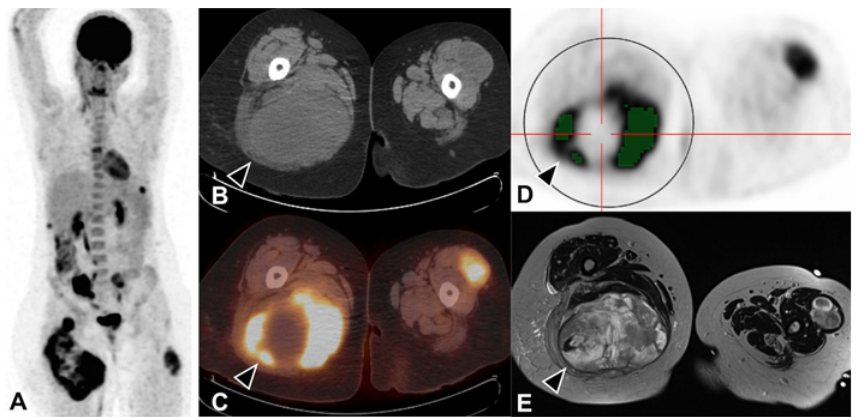
Fig 1. Example of a 19-year-old woman with rapidly growing peripheral neurofibroma in the upper right thigh ("at-risk" score = 25). (A) Maximum intensity projection. (B) CT image in axial view. (C) PET/CT fusion. (D) 18 F-FDG PET images after drawing a spherical volume-of-interest around the intramuscular tumour: the metabolic volume corresponds to the sum of voxels above a 41% SUV max threshold (green color). (E) Contrast-enhanced MRI. Metabolic measures suggest MPNST transformation (SUV max = 12.5, TMTV = 389 cm 3 , TLG = 2323, T/L ratio = 6.2), confirmed by histopathological study (sarcoma grade 3). To note, intratumoral heterogeneity is present in the right thigh mass (black arrow) although whole-body heterogeneity index is below the predictive threshold (HI suv = 1.68). Patient was treated with